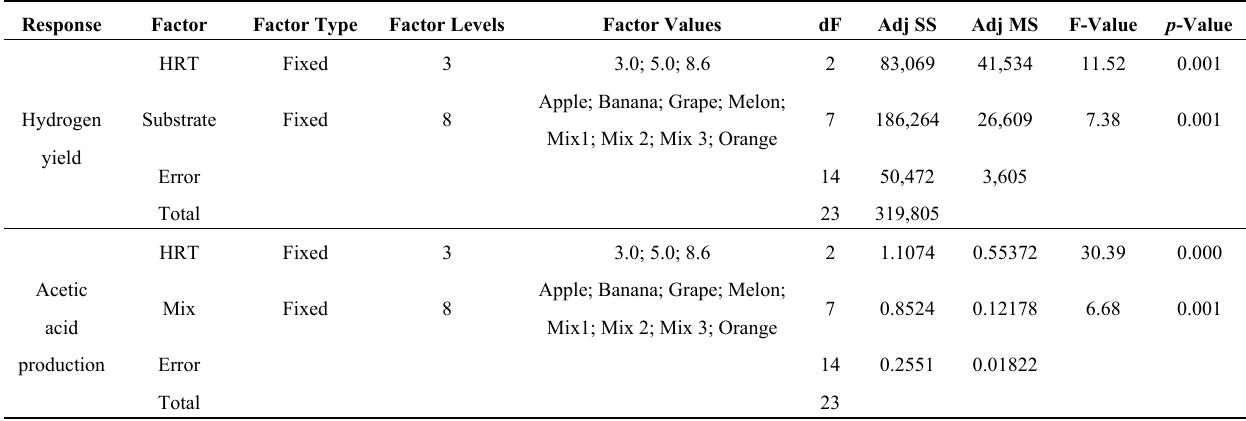
Table 5. Summary of two-way analysis of variance (ANOVA) for the effects of hydraulic retention time (HRT) and